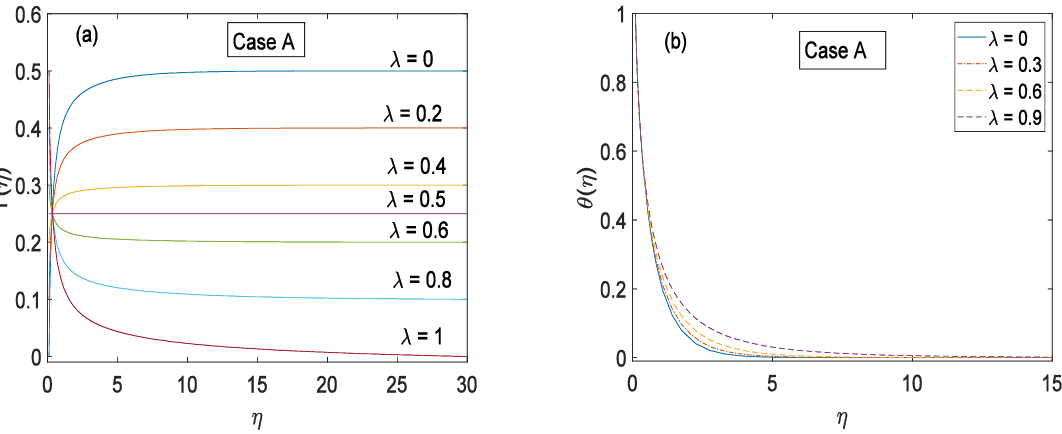
Figure 4. Velocity and temperature profiles for different values of parameter λ when Pr = 5, m = 0.1, (cid:101) = 0.5 and θ w = 1.27. Part ( a ) shows function f (cid:48) , while the function θ is plotted in part ( b ). In Figures 5 and 6, curves of θ are plotted for varying choices of parameters (cid:101) and Pr . Note that (cid:101) > 0 corresponds to the situation where thermal conductivity has a direct relationship with temperature. Thermal conductivity K ( T ) grows for increasing values of (cid:101) , which in turn enhances temperature profile. Furthermore, as the Prandlt number rises, the relative importance of heat conduction reduces due to which a reduction in θ is apparent.